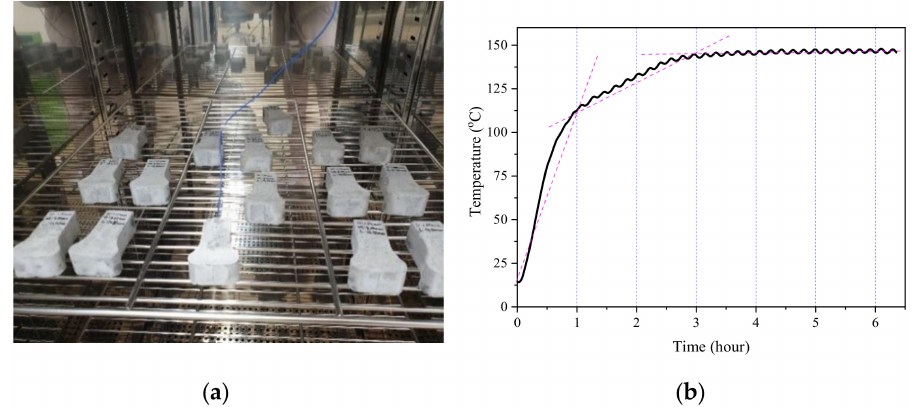
Figure 10. Time–temperature history of the heated specimens: ( a ) heating specimens; and ( b ) time–temperature